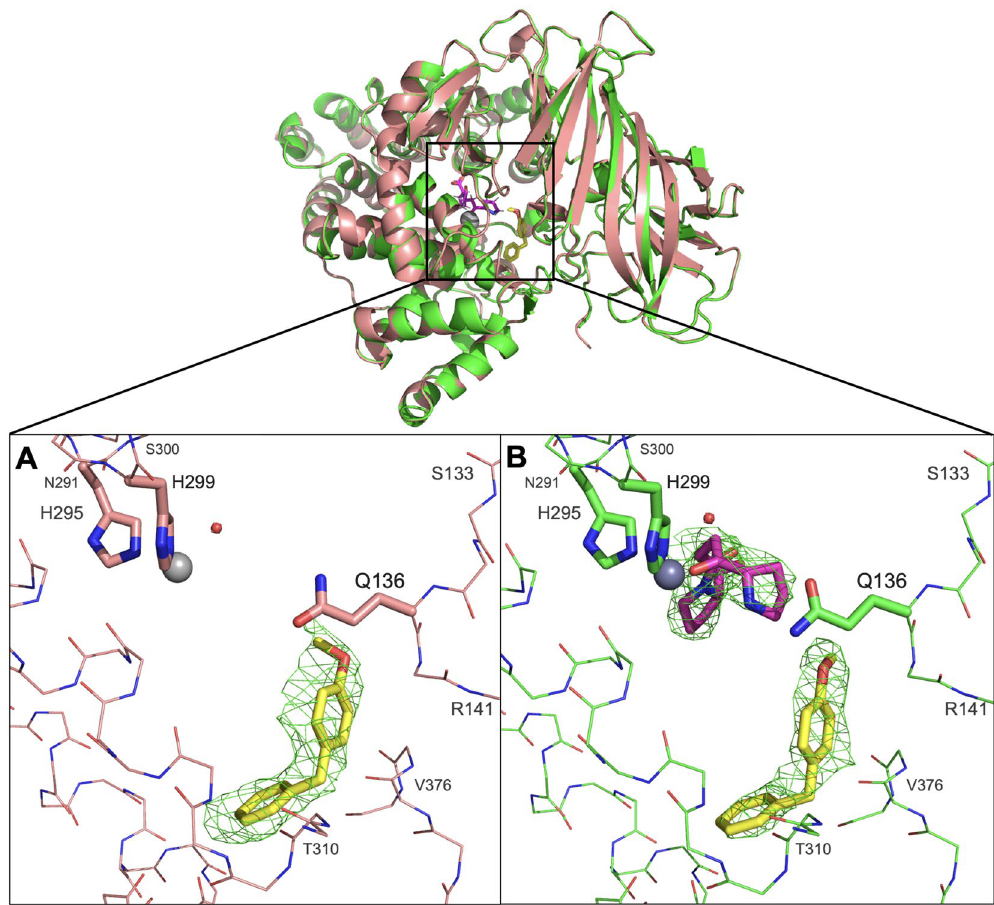
Figure 7. Superimposed crystal structures of LTA 4 H:4MDM and LTA 4 H:4MDM:OPB-Pro complexes (top). ( A ) A close-up view of the LTA 4 H binding pocket with 4MDM (yellow) bound within the short end of the L-shaped hydrophobic pocket of LTA 4 H (salmon) is shown. ( B ) A close-up view of the LTA 4 H binding pocket with both 4MDM (yellow) and OPB-Pro bound (green) is shown. Active site Zn 2+ and coordinating His residues are indicated. The direction of the Gln-136 side chain points toward the hydrophilic binding site with respect to water. The direction of the methoxy group in 4MDM is rotated in the tri-complex. Background residues were deleted to enhance the visibility of the binding site except for residues from Ser-133 to Arg-141, from Asn-291 to Ser-300, and from Thr-310 to Val-376 are shown in line